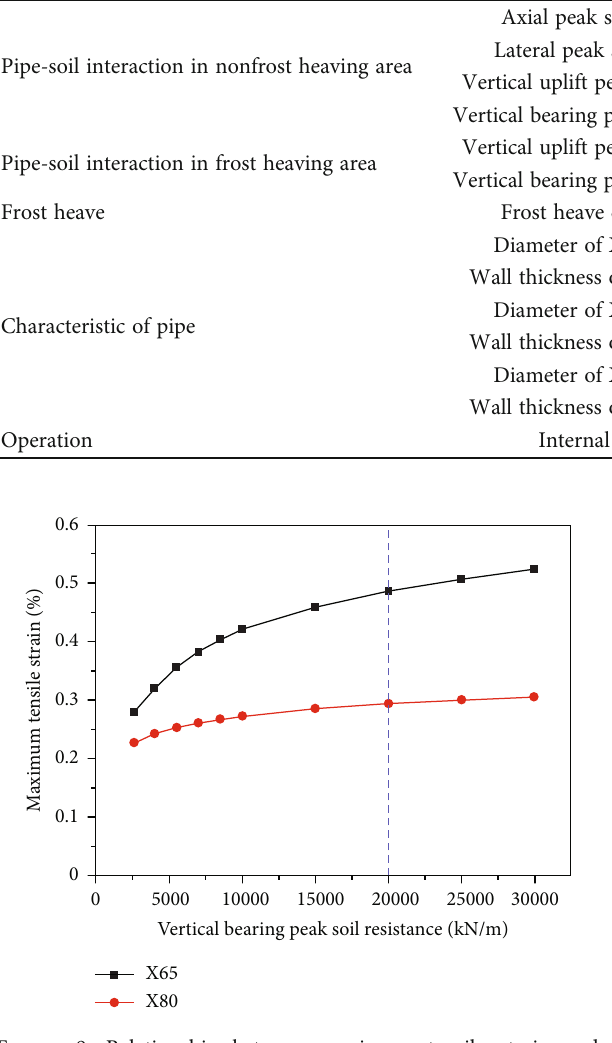
Figure 9: Relationship between maximum tensile strain and vertical bearing peak soil resistance of frozen soils.